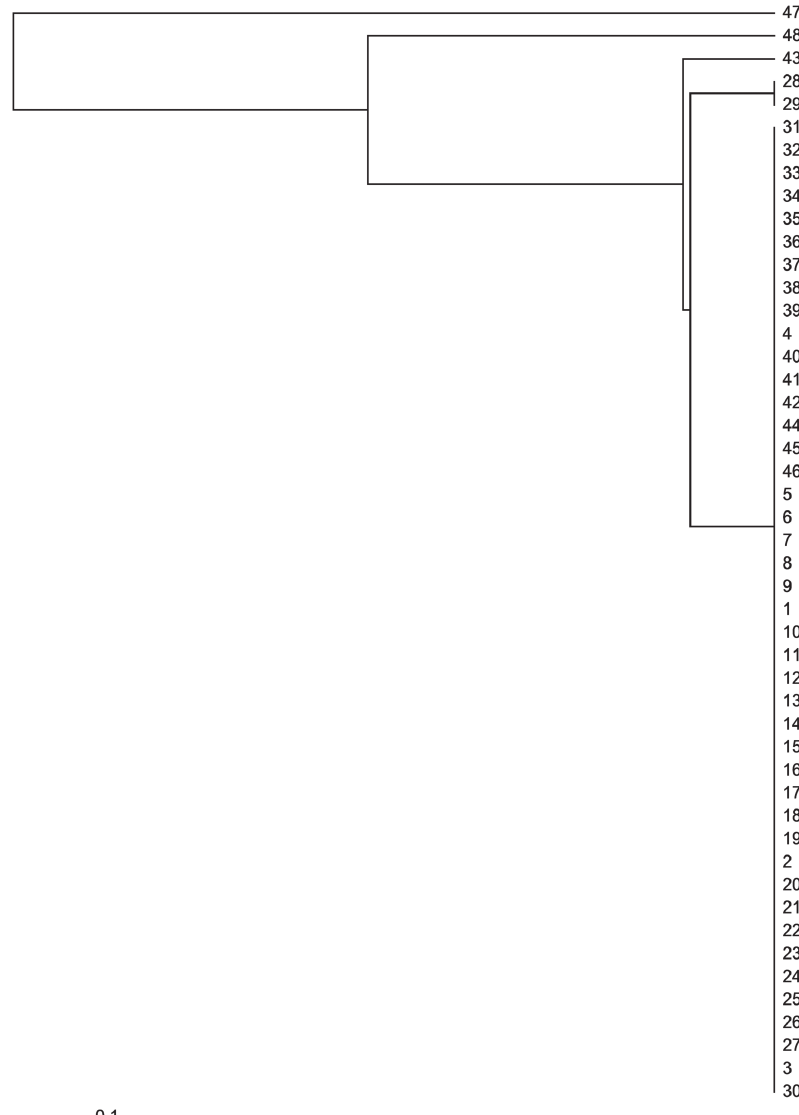
Figure 3 - UPGMA phenetic tree obtained using data from the ISSR markers, showing the genetic relationships among the 48 of jatropha accessions, identified according to Table